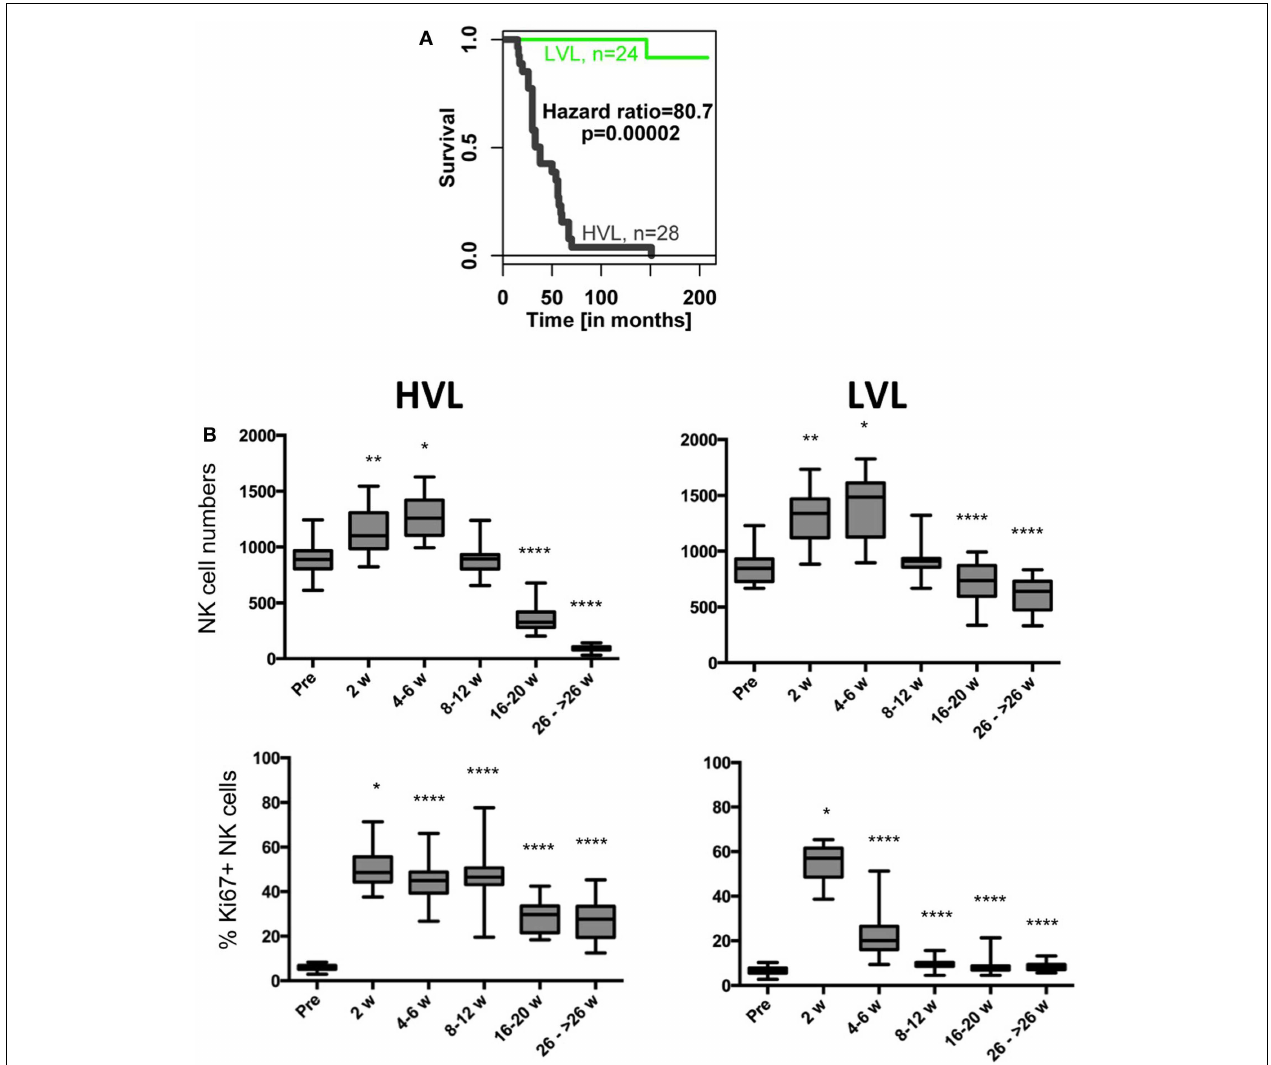
panel). Sampling of cells was before infection (pre) and at indicated weeks after infection. t -Tests were performed between the cell numbers of corresponding time points and were indicated as * p < 0.05; ** p < 0.01; **** p <